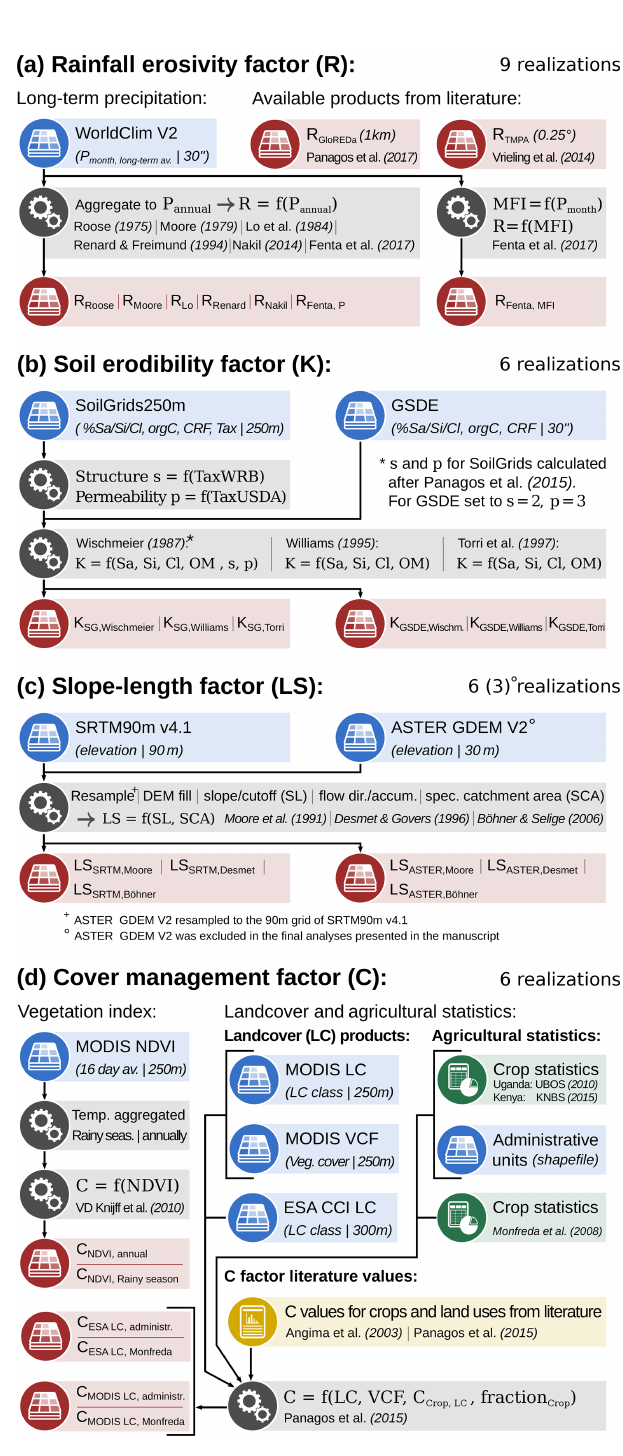
Figure 2. Methodological framework to generate the realizations of the USLE model input factors R , K , LS, and C